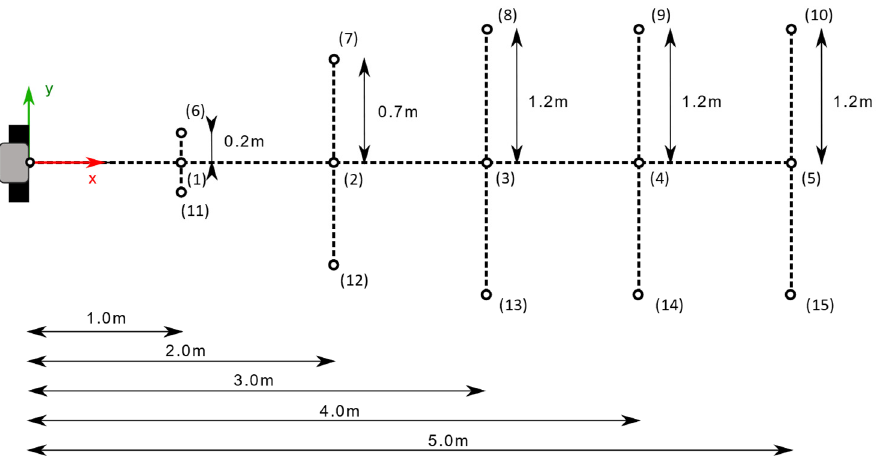
Figure 3. The grid arrangement of the target object locations for testing. Numbers in parentheses denote the location identifiers. Kinect cameras and the laser scanner are located at the origin of the coordinate system. The Kinect cameras are in the same orientation for every target location, such that the optical axis of either camera is always aligned with the x-axis.